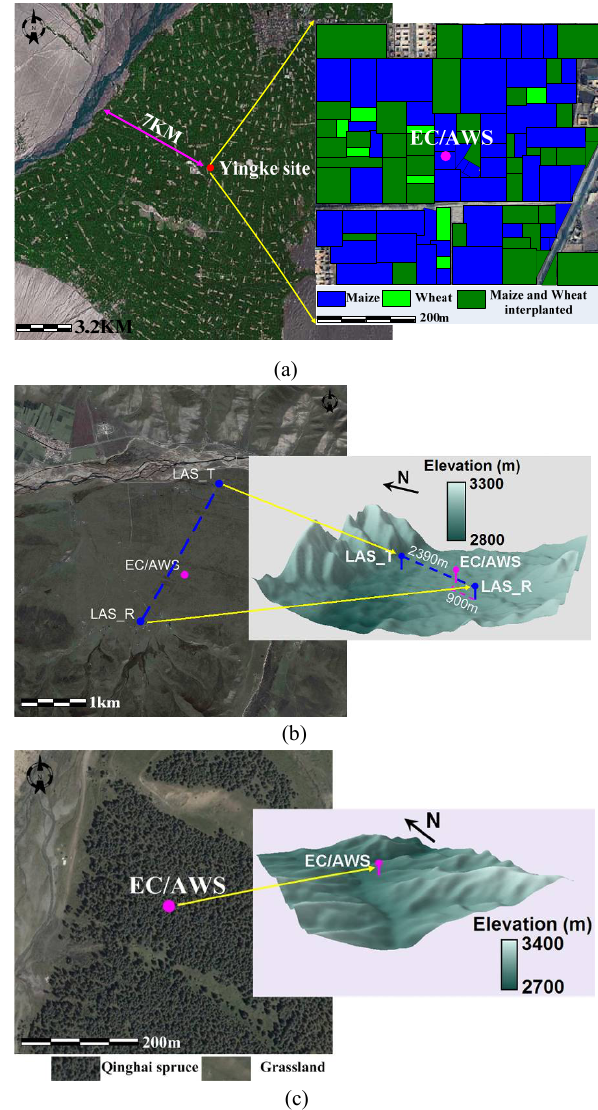
Fig. 2. Overview of the observation sites: (a) YK; (b) AR; and (c) GT. The (a) and (c) images were created using Google Earth (version 5.0), 2 February, 2009. (b) was a Quickbird image, August 2009. A digital elevation model was also plotted in (b) and (c).